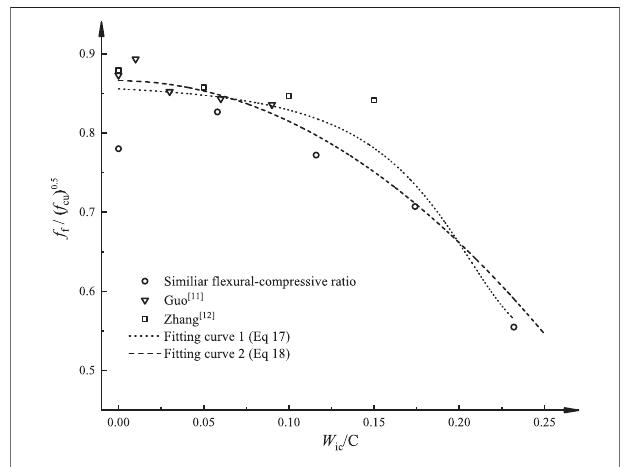
FIGURE 5 | The relationship of the internal curing water-cement ratio and f f / ( f cu ) 0 . 5 .